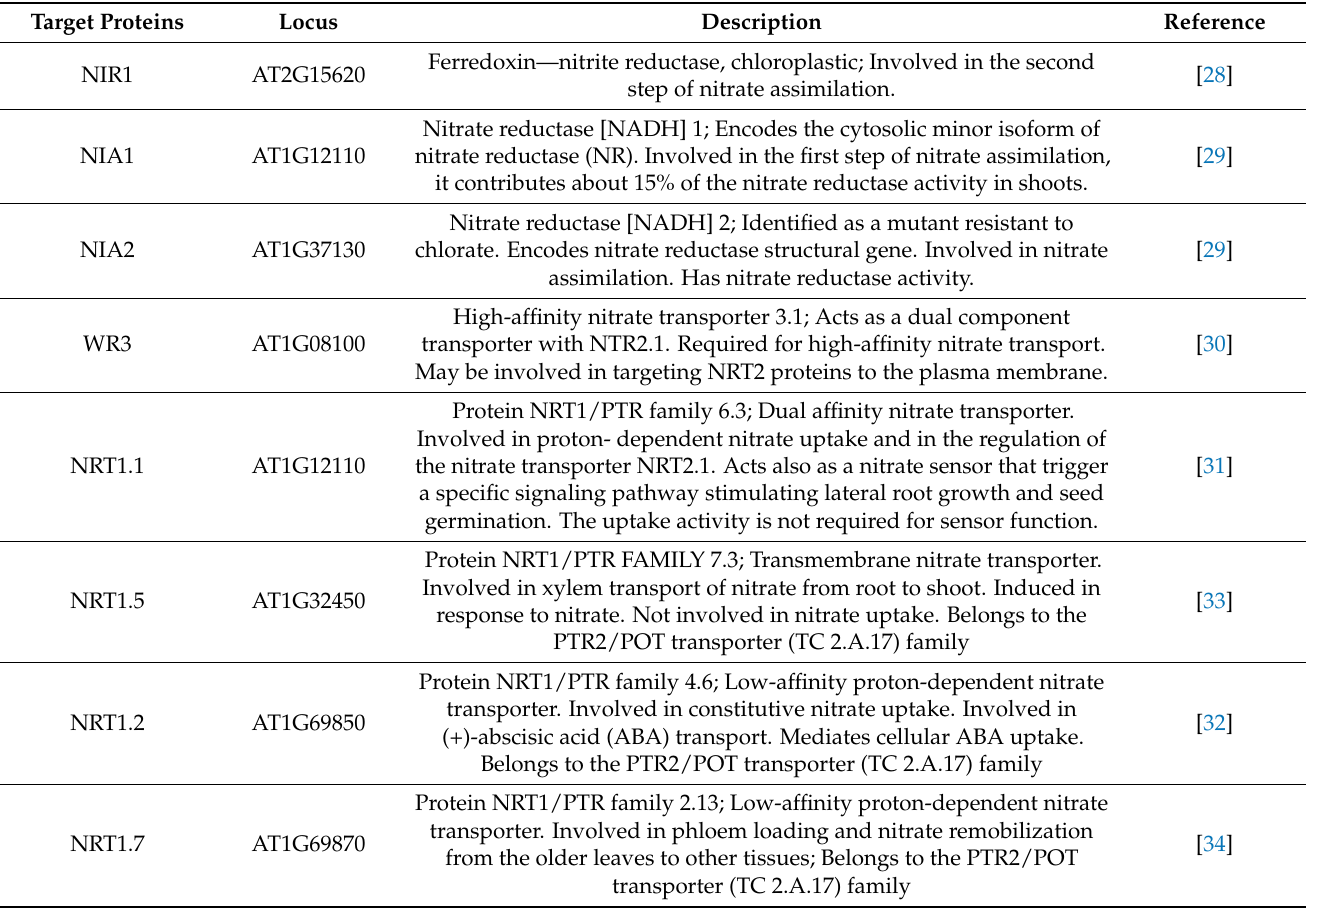
Table 2. Predicted protein–protein interactions involving AtNRT2.2 (topmost upregulated by drought stress). Target Proteins Locus